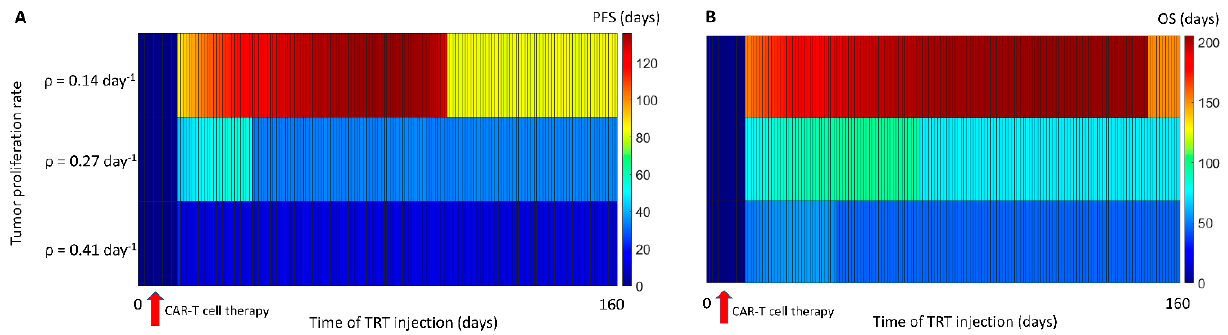
Figure 7. Impact of the tumor proliferation rate on PFS and OS tumor growth. ( A ) PFS. ( B ) OS. Paradoxically, a faster growing tumor results in lower PFS and OS due to a greater response to the treatments. This suggests that the interval between the therapies should be smaller for faster growing tumors.